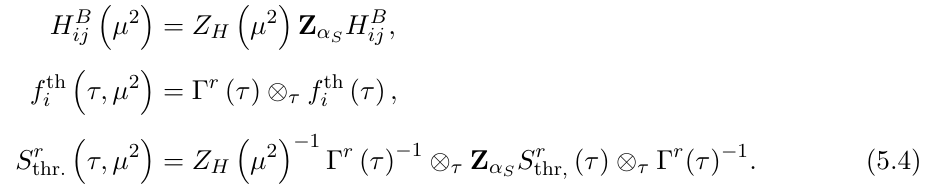
Figure 2 . Cut diagram for the one real emission correction to the threshold soft function S r color singlet production. Doubled lines represent Wilson lines that trace the path of the initial state partons involved in the hard scattering process. The wiggled line represents a radiated gluon which crosses the final state phase space cut indicated by the dashed